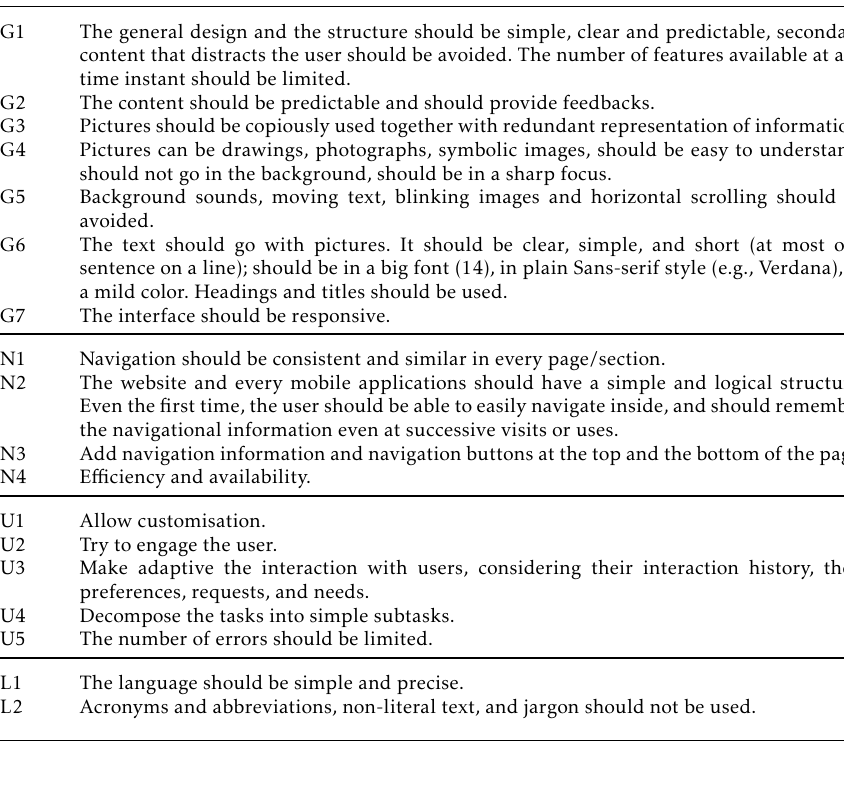
Table 1. Accessibility and usability guidelines for users with